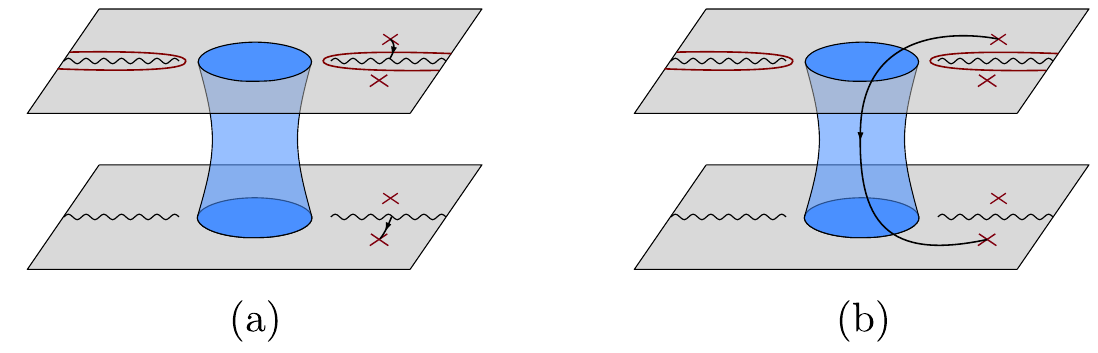
Figure 9 . We consider a global state which is not the vacuum but contains some operator insertions in the bath region. (a) The diagonal contribution to the density matrix comes from particles propagating through the cuts. (b) Off-diagonal contributions come from world-lines with non-zero net charge propagating through the